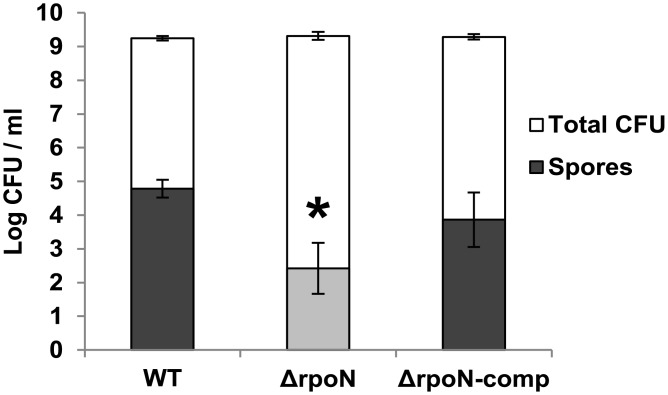
Spore formation.Number of spores and total viable counts in BHI formed by B. cereus ATCC 14579 WT, ΔrpoN and ΔrpoN-comp in BHI following aerated growth at 30°C for 48 h. The asterisk indicates significant difference (student’s t test, p<0.05) of the ΔrpoN compared to both the WT and ΔrpoN-comp.